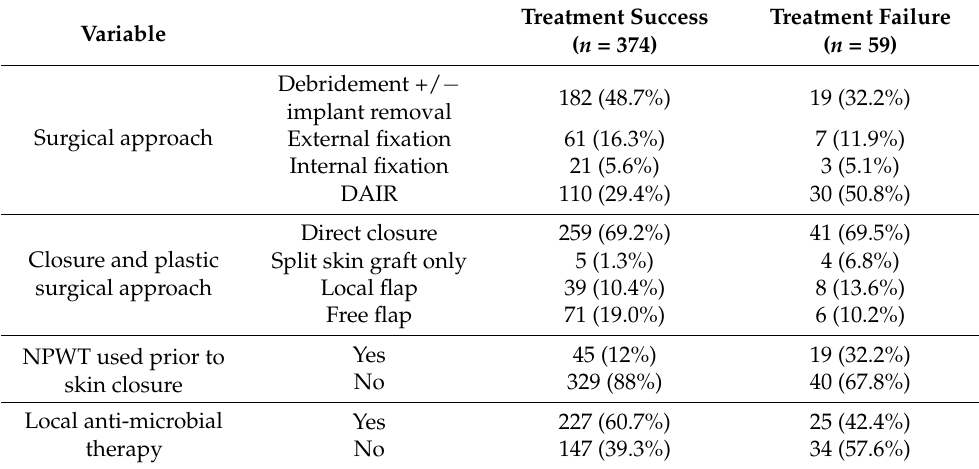
Table 2. Treatment strategy related to treatment